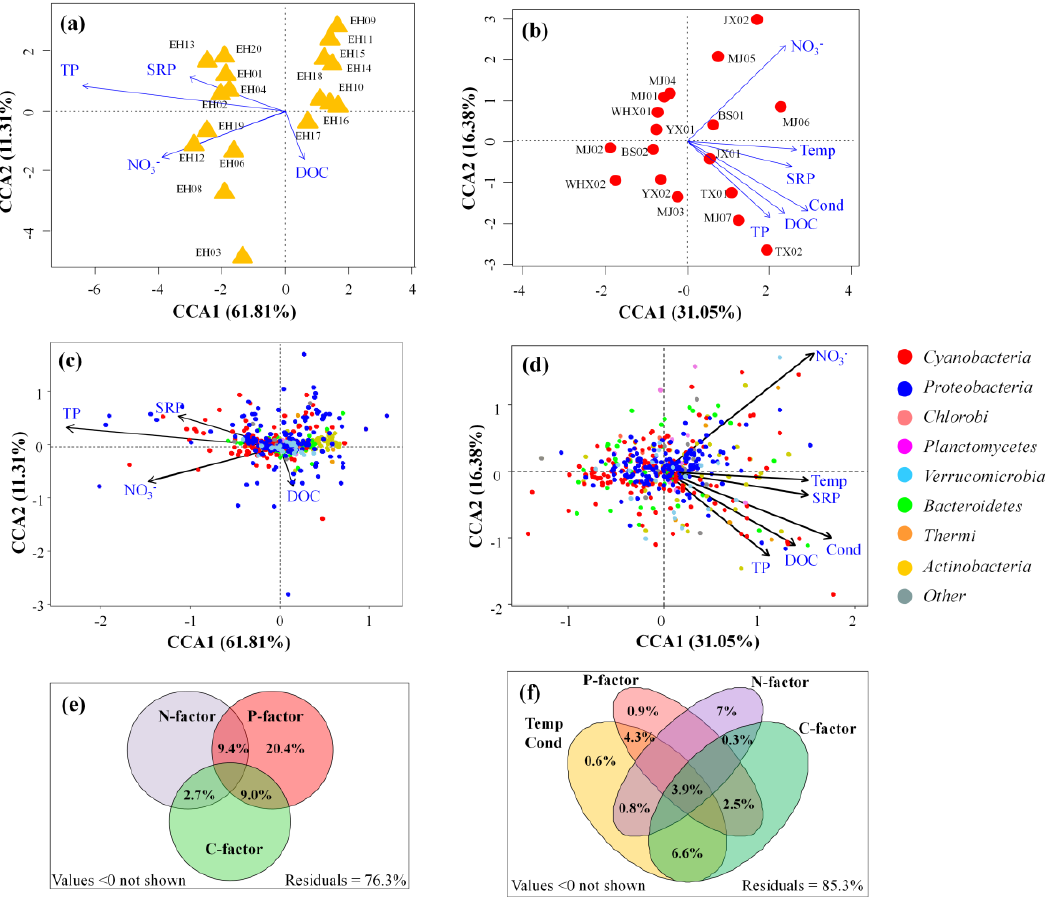
Figure 7. Canonical correspondence analysis (CCA) of bacterial communities and nutrient variables in Erhai Lake ( a, c, and e ) and streams ( b, d, and f ). All environmental variables had goodness of fit at the significant level p < 0.05 by envfit function. Variance partition analysis (VPA) determined the relative contributions of physicochemical factor, C-factors (DOC), N-factor (NO 3 − ), P-factor (TP and SRP), and the interactions of these factors in Erhai Lake ( e ) and streams ( f